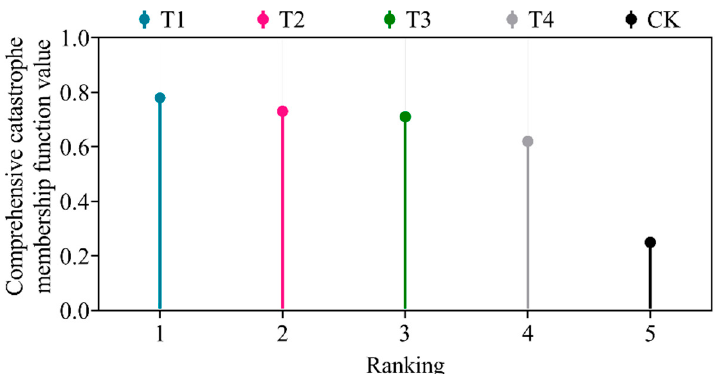
Figure 8. Comprehensive evaluation results of each irrigation treatment.